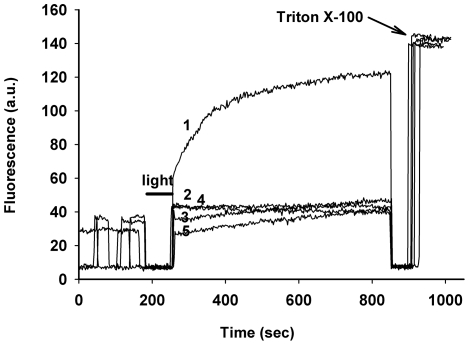
Oxidative photodamage of liposomes in the presence of compound 5.The SRB-containing EggPC liposomes were suspended in PBS and either mock-treated or exposed to red light in the presence of 350 nM of 5 alone or 5 and 10 mM NaN3. A line bar and an arrow indicate the time of LI and the addition of 0.1% Triton X-100, respectively. Liposome photodamage was registered as an increase of SRB fluorescence in the extra-liposomal milieu. Shown is one representative experiment out of 3 independent replicates.